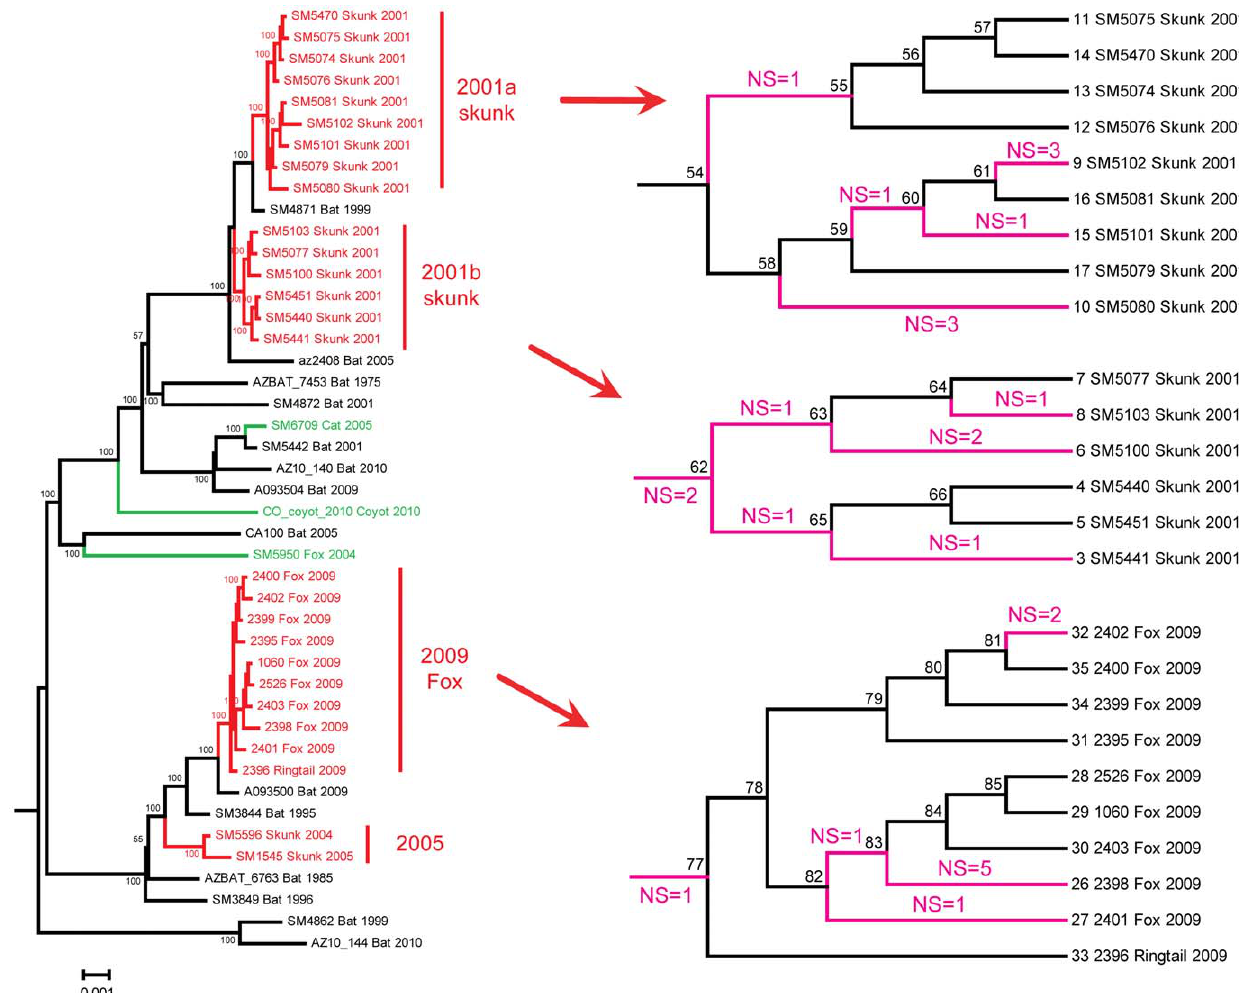
Figure 3. Reconstruction of post-host shift amino acid changes. Left: Bayesian tree of EF-W1 lineage, based on the entire coding region of G gene (1572 nuc). The branches involved in host-shift are marked with red. The amino acid changes occurred within these branches were defined ‘‘post-host shift’’ changes. Other branches that lead to terrestrial mammal RABV are marked with green. Right: the magnification of the three clusters involved in the Flagstaff host shifts. For clarity, the branch length did not reflect substitutions per site. The branches with non-synonymous changes are marked with pink, and numbers of changes are shown above and below. For more details see Table 2.